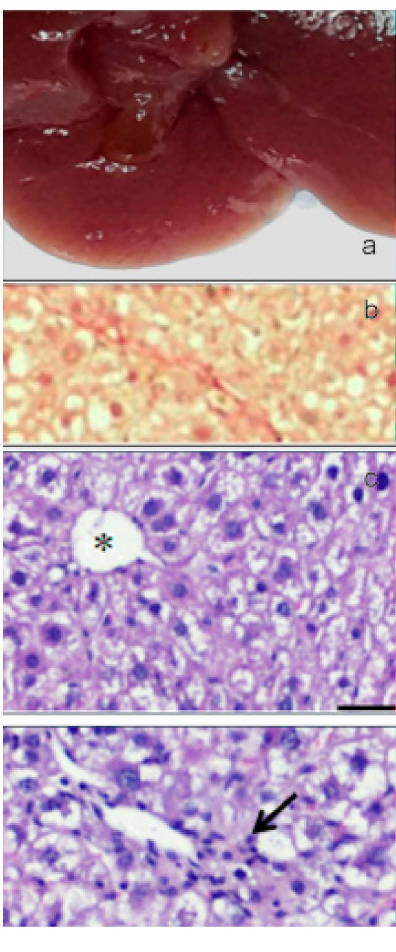
Figure 14. ( a ) Image of the gross morphology of the liver showing an improvement of the pathological changes induced by CCl 4 challenge in the CCl 4 + paramylon nanofibers group in which the normal tissue consistency was almost restored. ( b ) Picrosirius red staining of liver sections: reduction of the amount of collagen deposition respect to the challenged group by paramylon nanofibers treatment. ( c ) Reversal of severe inflammation and vein congestion along with a milder vacuolization of hepatocytes (upper image). The infiltration of inflammatory cells, although still present, is greatly reduced (bottom image, arrow). Asterisk indicates the central vein and star indicates the portal vein. Bar 50 µ